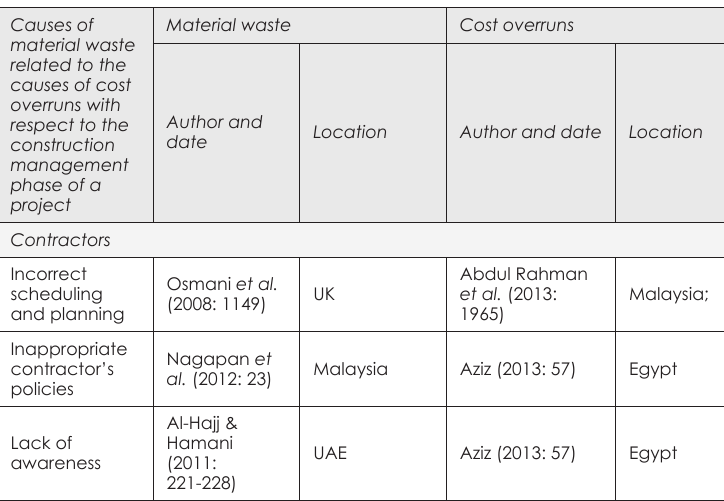
The relationship between the causes of material waste and cost overruns with respect to the quality of construction